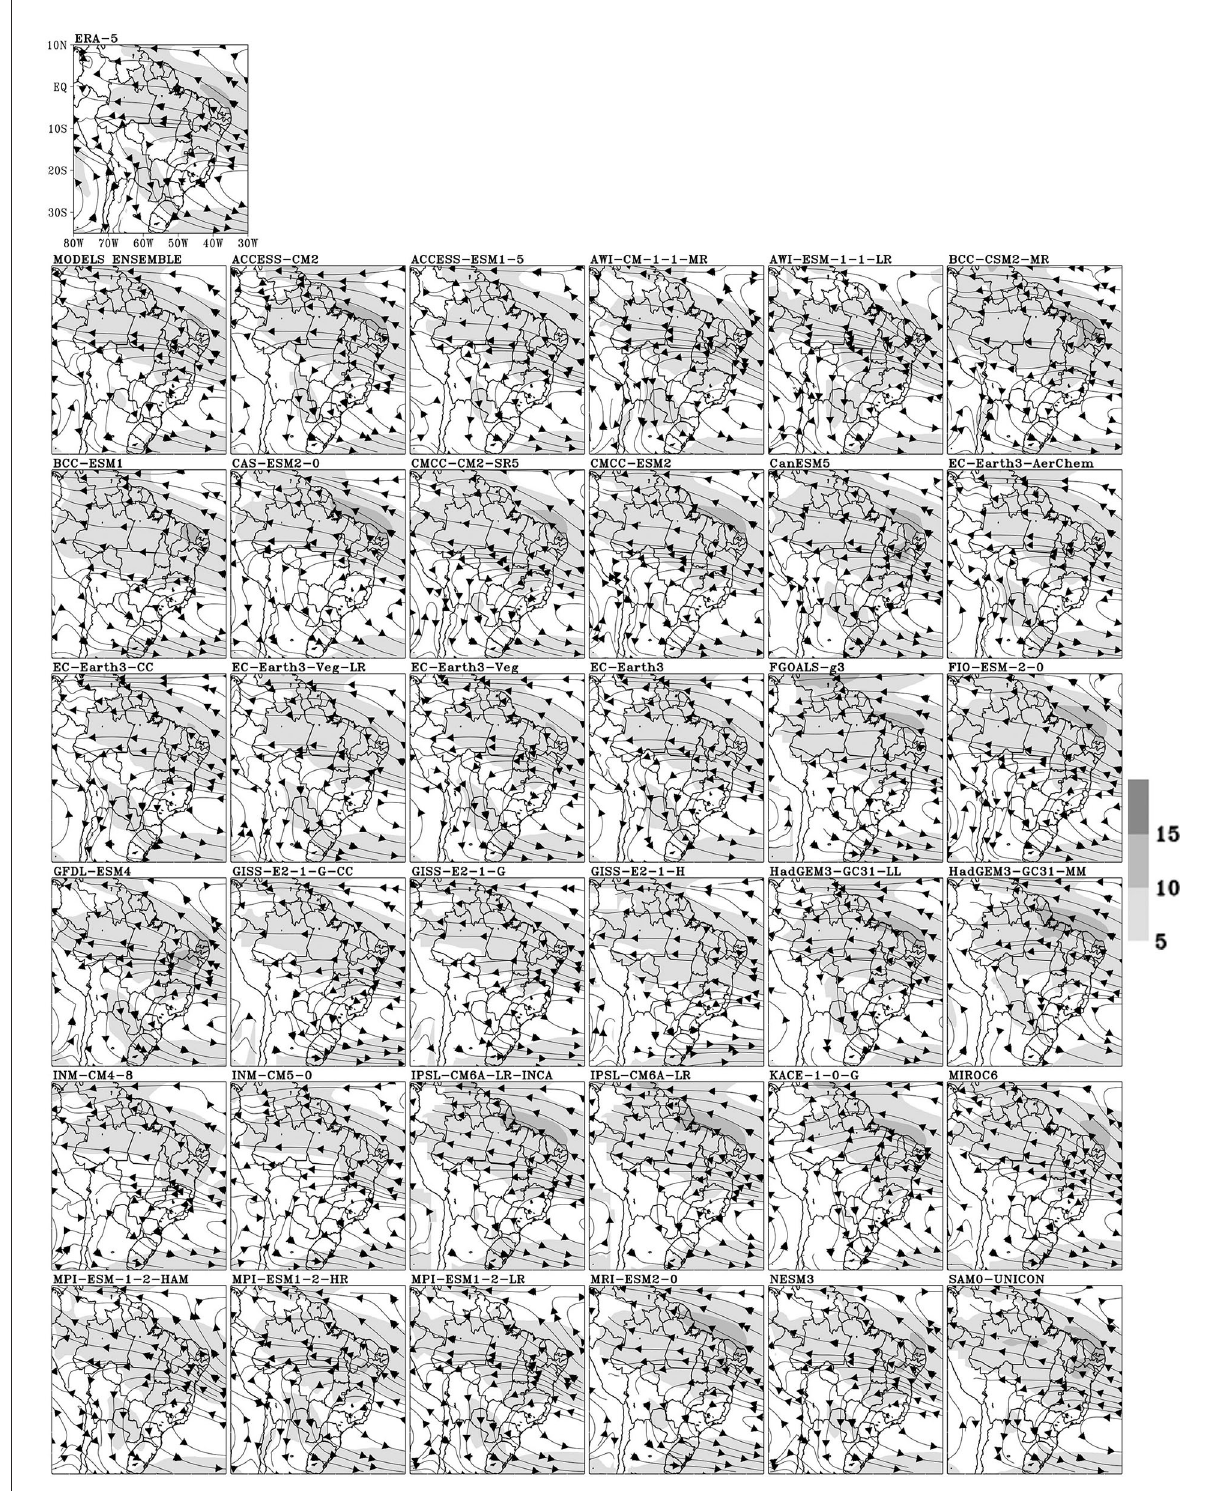
FIGURE3 Streamlines and magnitude of climatological winds (m/s) at 850 hPa simulated by the multi-model ensemble mean, individual CMIP6 models, and ERA-5 reanalysis (top left) for austral winter (JJA) during the historical period. The shaded regions represent wind magnitude starting from 5 m/s while the vector shows the wind